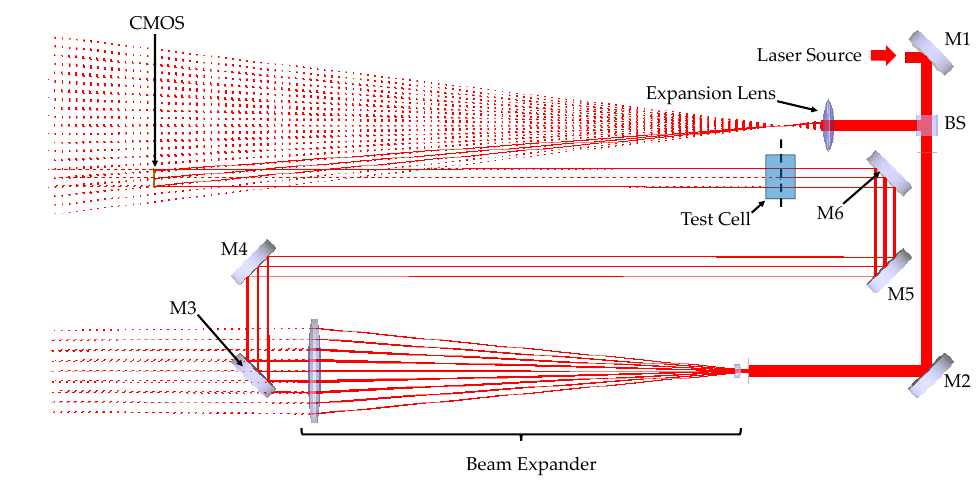
Figure 3. Raytraced FRED model of the LFTDH interferometer.